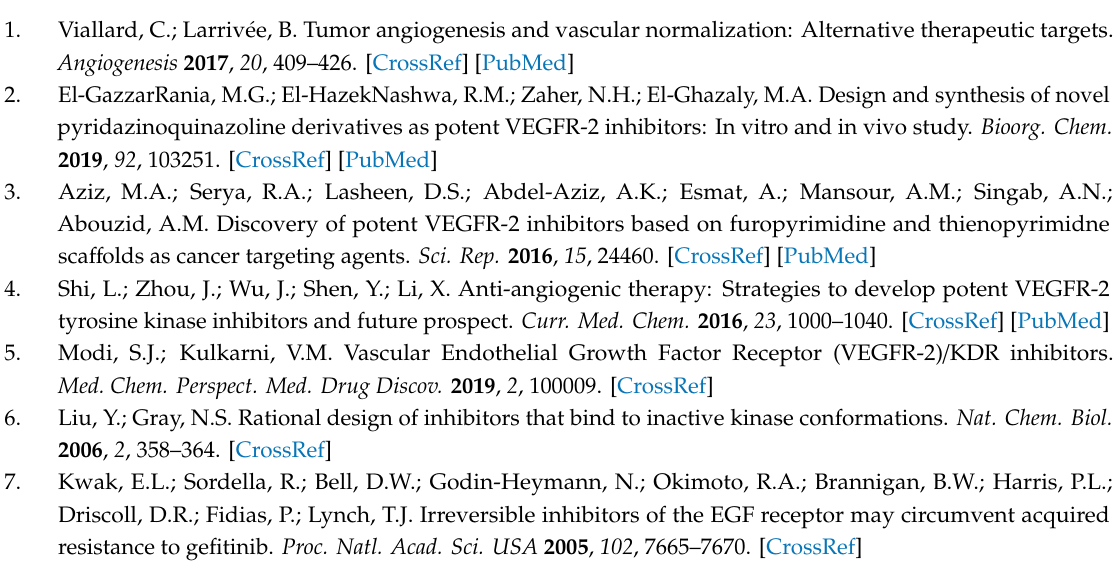
Supplementary Materials: The following are available online. Table S1: Equations 1–6. Table S2: Minimum recommended values of validated parameters for generally acceptable QSAR. Table S3. Correlation matrix of from PLS analysis for HepG2 variables. Table S4. Correlation matrix of from PLS analysis for MCF7 variables. Table S5. Chemical structure of 2-thioxobenzo[ g ]quinazoline derivatives and their cytotoxicity activities on HepG2 and MCF7. Table S6: Statistical Validation Results of QSAR Model for HepG2 & MCF7 cell line. Figure S1: Dose-dependent antiproliferative data of the compounds on the HepG-2 human cancer type, according to the MTT assay after 48 h of exposure. Figure S2: Dose dependent antiproliferative data of the compounds on the MCF-7 human cancer type according to the MTT assay after 48 h of